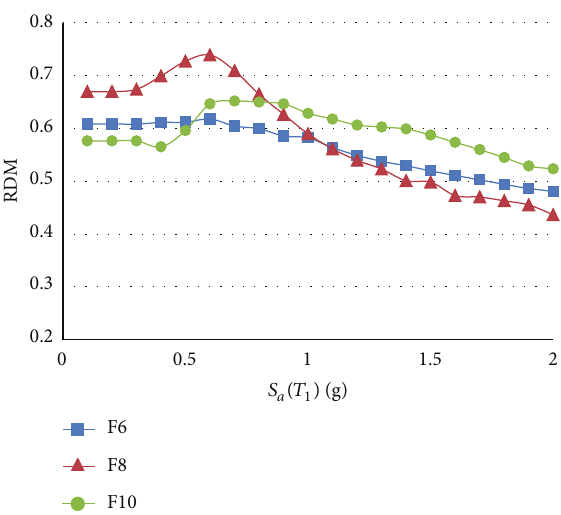
Figure 7: Ratio of median values of IDR max for FPTC divided by IDR max for